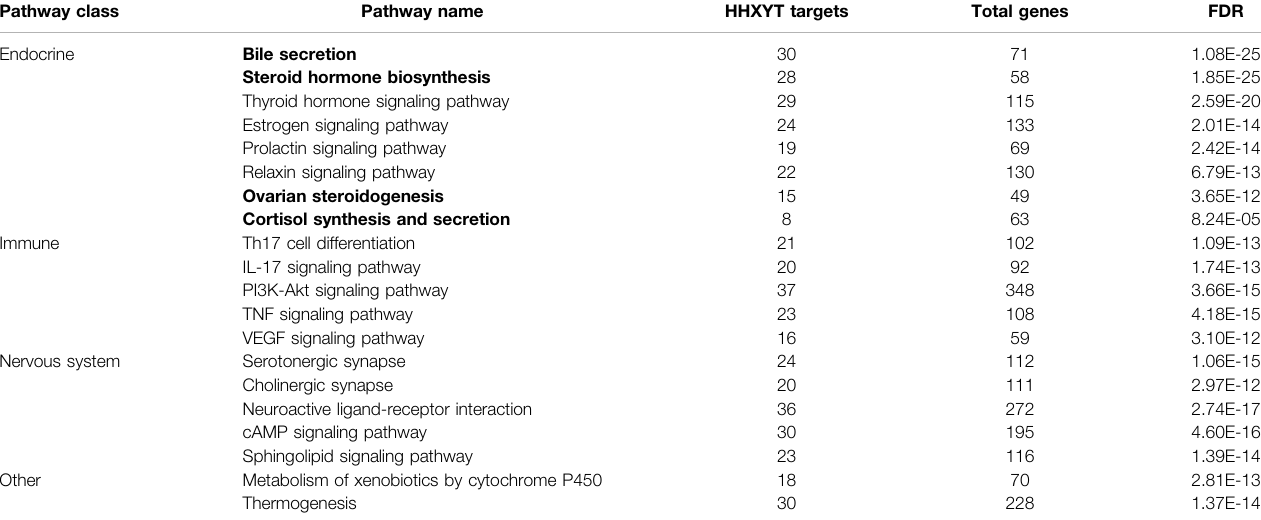
TABLE 2 | Enriched KEGG pathways of HHXYT ’ s targets. The pathways with bold type are associated with metabolic modules affected by HHXYT. Pathway